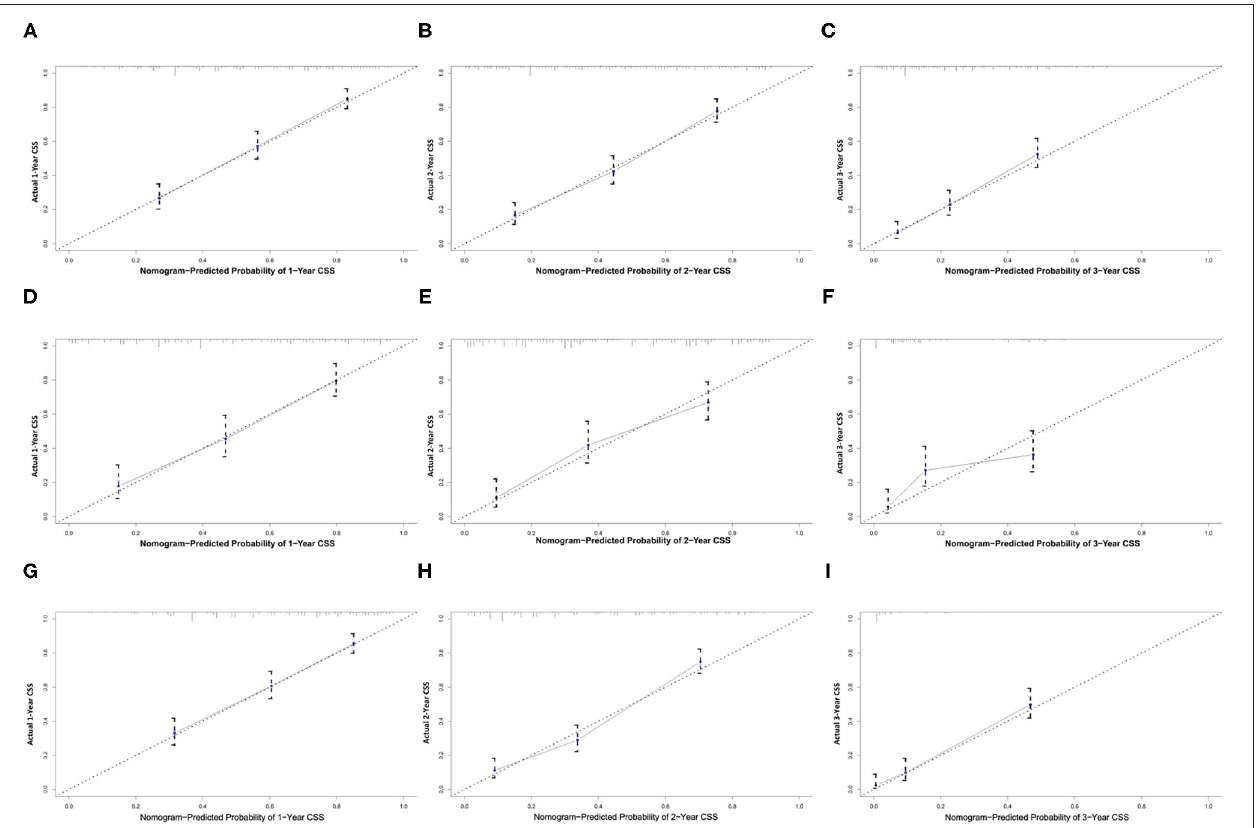
FIGURE 5 | Calibration plots of the nomogram for 1-, 2-, and 3-year CSS prediction of the training set (A–C) , internal validation set (D–F) , and external set (G–I) . X-axis represents the nomogram-predicted probability of survival; Y-axis represents the actual CSS probability. CSS, cancer-specific